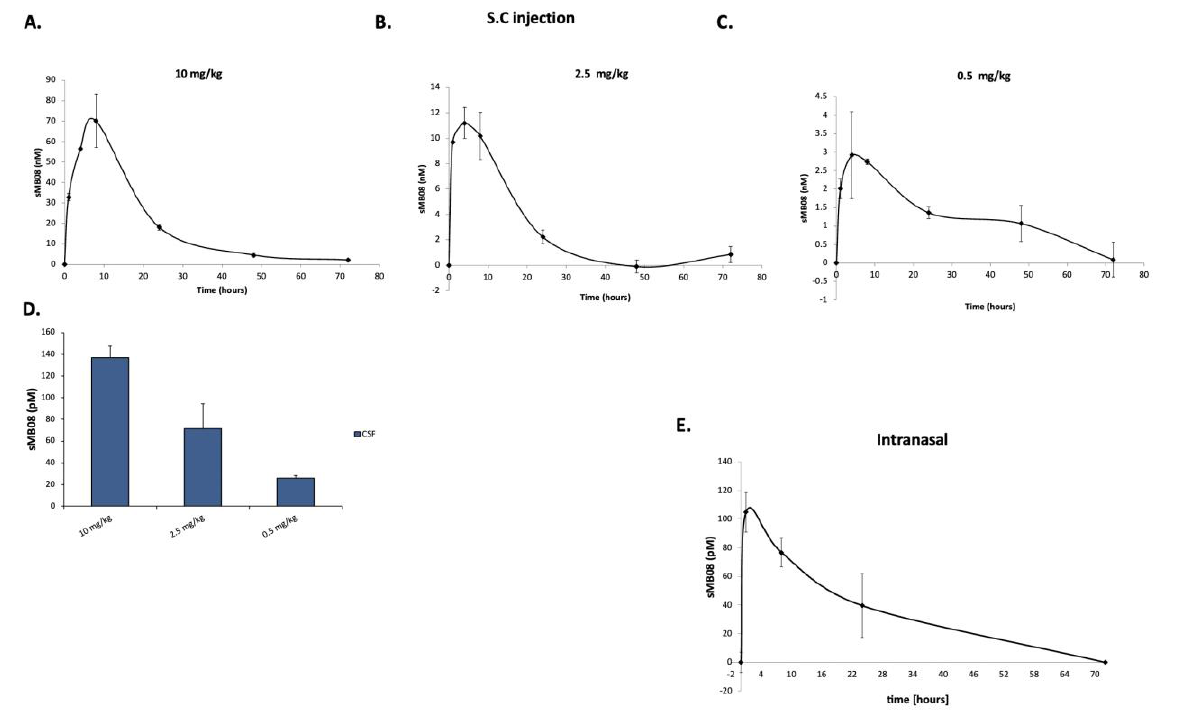
Figure 7. Pharmacokinetic analysis of sera and CSF in treated rats—sMB08 levels in rat serum in three doses of SC treatment: 10 mg/kg ( A ), 2.5 mg/kg ( B ) and 0.5 mg/kg ( C ). sMB08 levels in rats CSF 24 h post treatment ( D ). Error bars represent standard deviation of the mean. ( E ) sMB08 levels in murine brains. Error bars represent standard deviation of the mean.